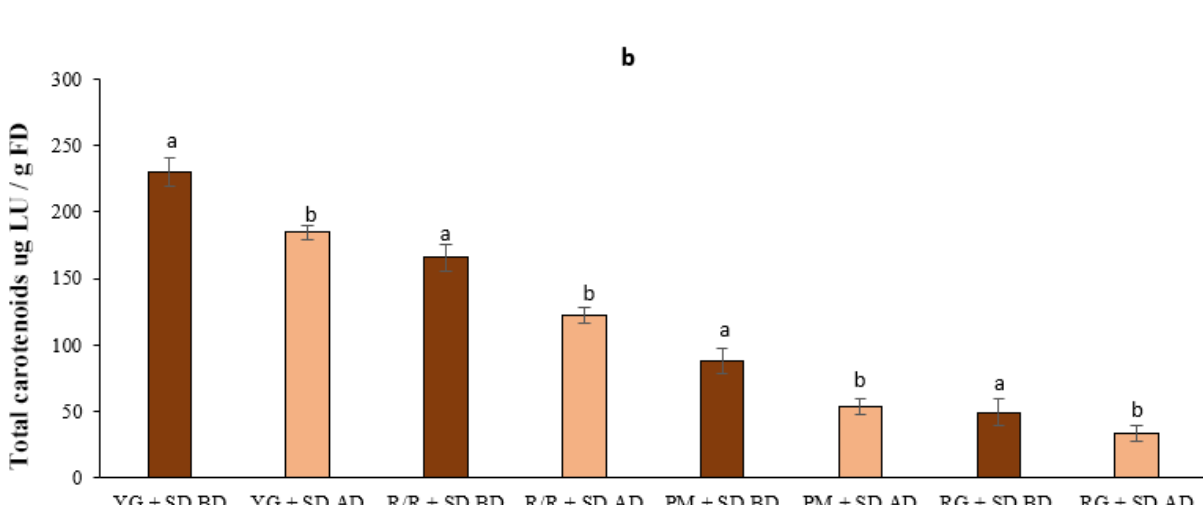
Figure 3. The levels of total carotenoids and bioaccessibility of cooked potato cultivars mixed with roasted JP ( a ) and roasted SD ( b ). Data are the mean of three replicates with standard deviation and are expressed as per gram of freeze-dried weight. Significant differences are denoted by different letters, while the same or shared letters indicate that they are not significant to each other. BD and AD: before and after digestion.